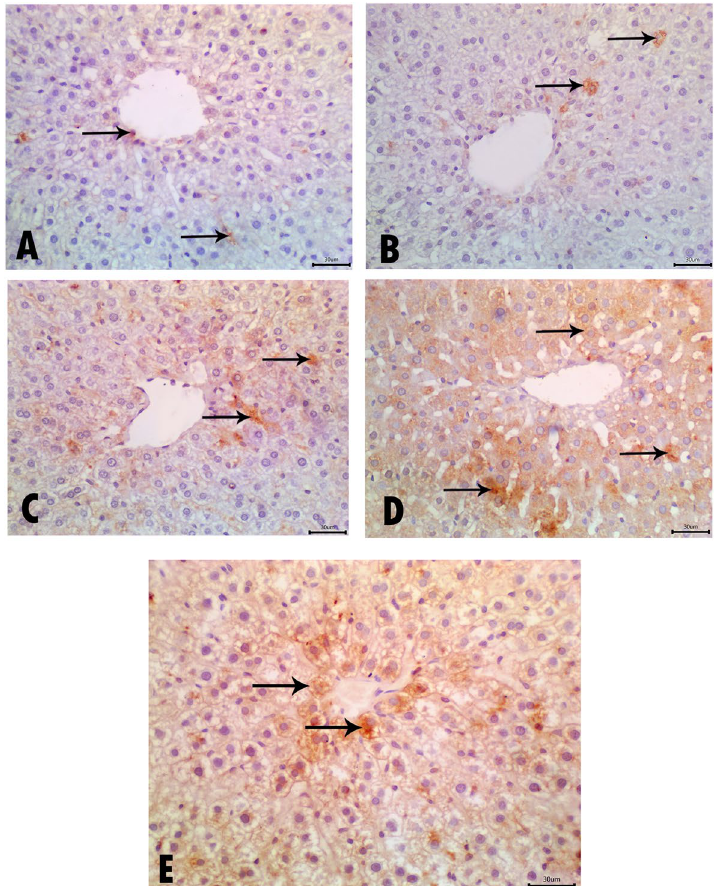
Fig. 9 Photomicrographs of sections in the liver immunohistochemically stained with cannabinoid receptor 1 (CB1) ( positive control groups show few positive reactions in the cytoplasm of hepatocytes (arrows). C The acute treated group shows positive immune hepatocytes (arrows). D Chronic treated group reveals an increased positive reaction in hepatocytes (arrows). E Chronic withdrawal group shows a decrease in positive reactions in hepatocytes (arrows) compared to the chronic